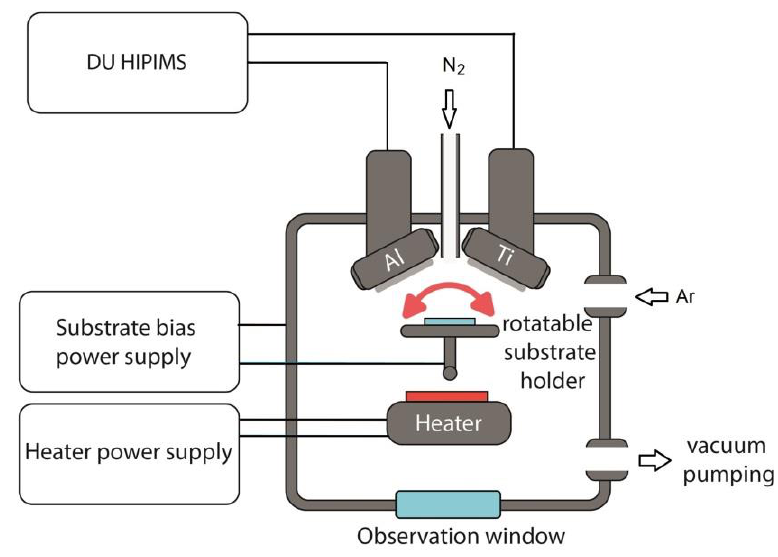
Figure 1. Schematic of the dual-HiPIMS vacuum installation [30].